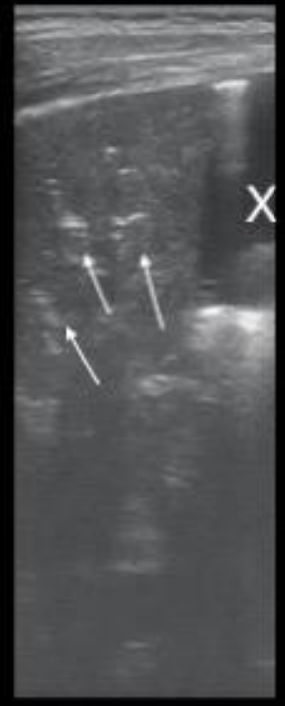
Figure 1. “Liver-like” Consolidation, with hyperechoic lenticular air (white arrows), consistent with air bronchogram; adjacent anechoic pleural effusion marked with X; LUS, 7 – 12 MHz.